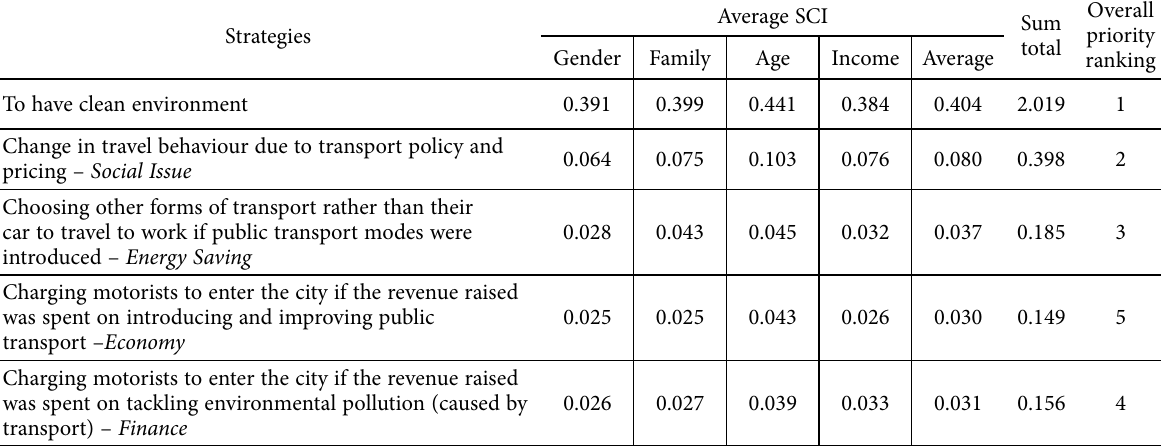
Table 4. Priority ranking of sustainable transport strategies for Tabuk City of the Saudi Arabia